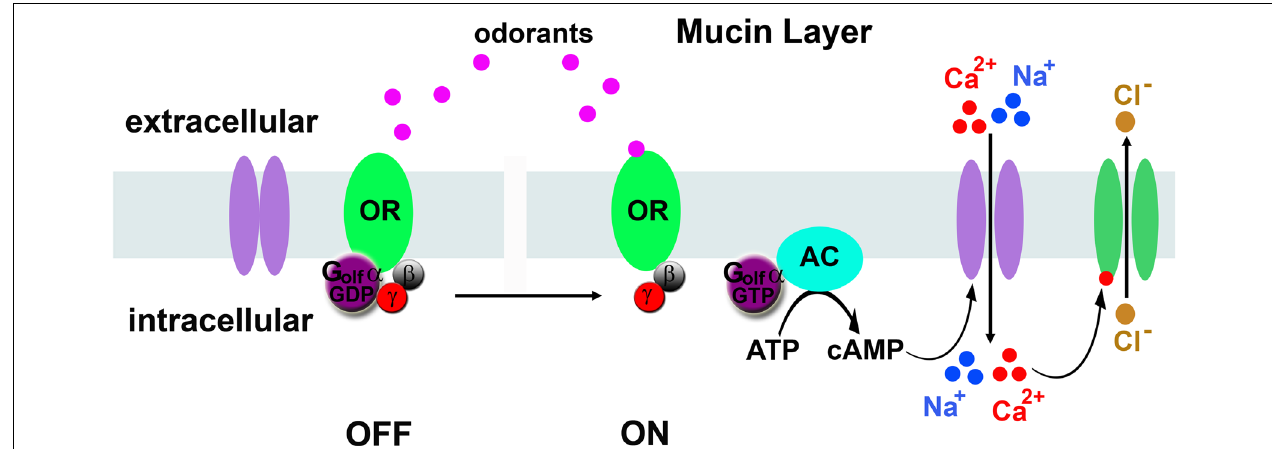
FIGURE 1 | Model of vertebrate olfactory signal transduction. In the absence of odorant (left), the odorant receptor (OR) is bound to the GDP-bound form of G . Activation by odorants (right) causes exchange of GDP for GTP by olf the alpha subunit of G , which activates adenylyl cyclase (AC) to produce cAMP. olf